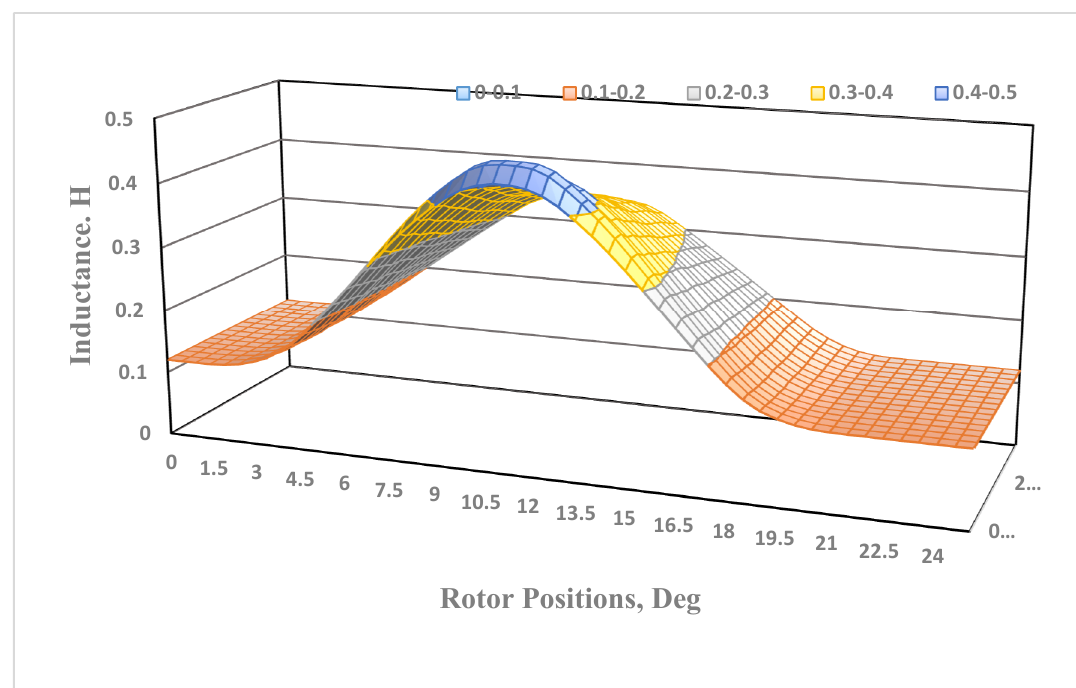
Figure 4. Torque-winding inductance profile at different phase currents.